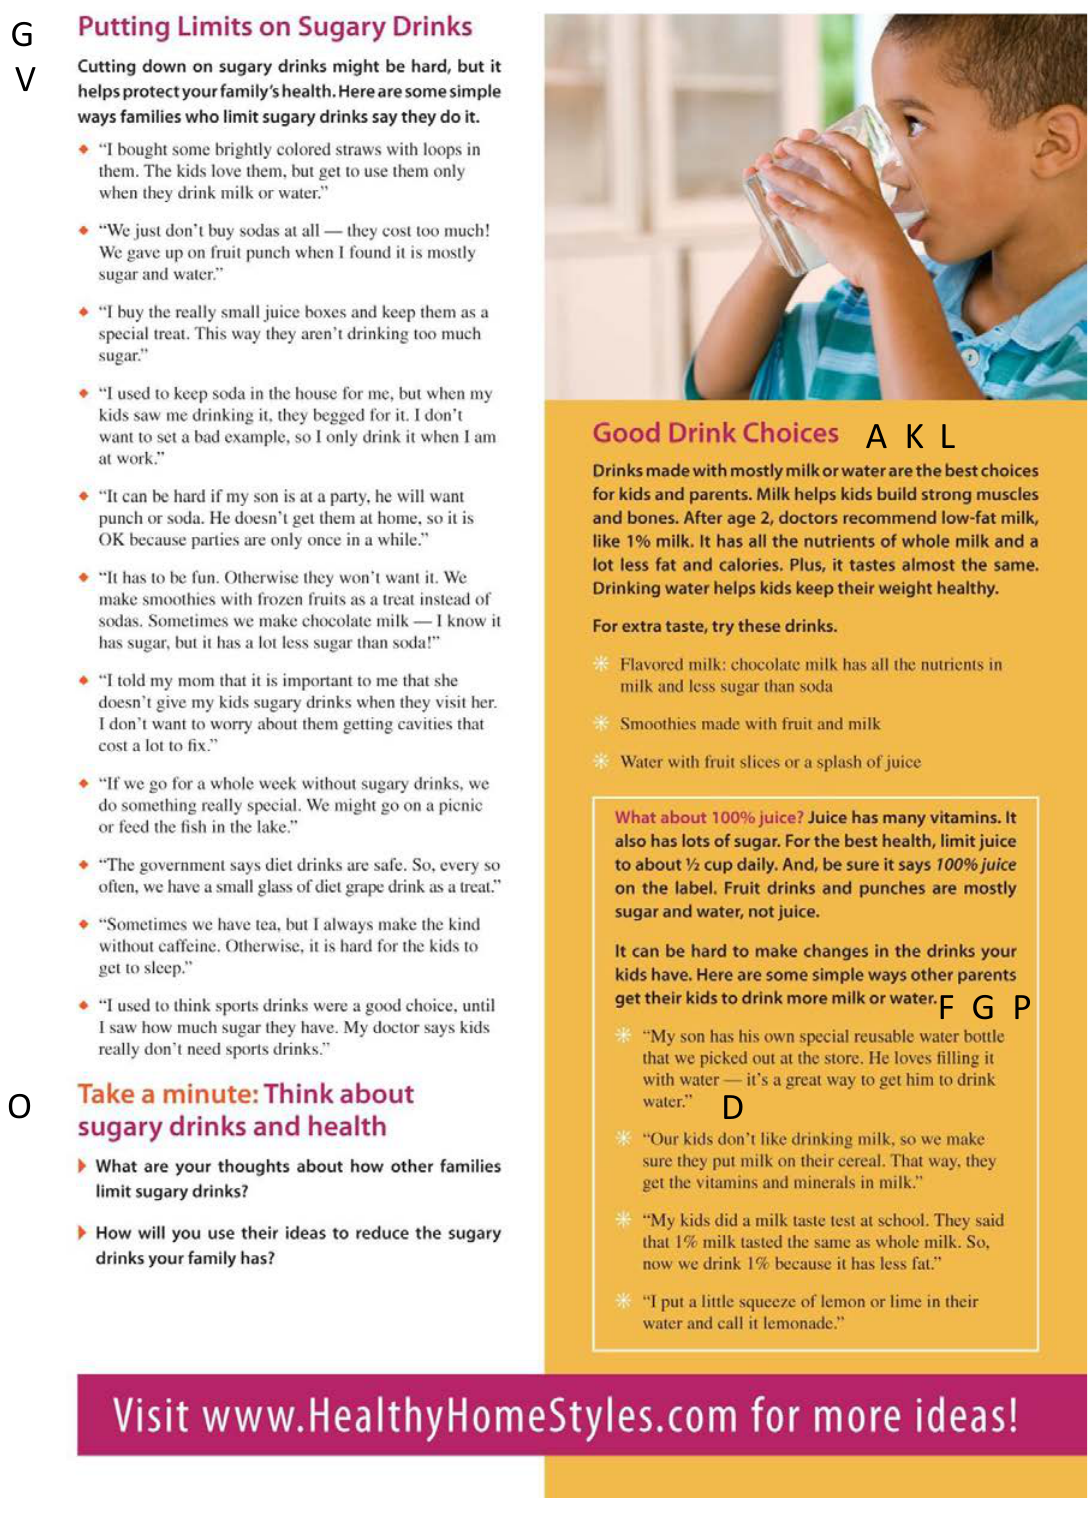
Figure 2. Cont Figure 2. Cont.